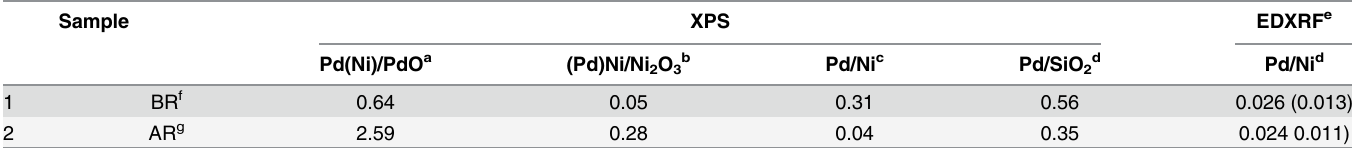
Fig 1. Representative SEM and TEM images of the Pd/Ni catalyst (a-c: t-Ni; d: p-Ni system). a — SEM image of the Pd NPs aggregates (e.g., indicated by arrows) on the Ni surface; b — TEM bright field image containing the electron diffraction pattern of Pd particles in the corner, c — TEM dark field images of the Pd nanocrystalline aggregates on the Ni surface; d — HRTEM image of the Pd NPs.